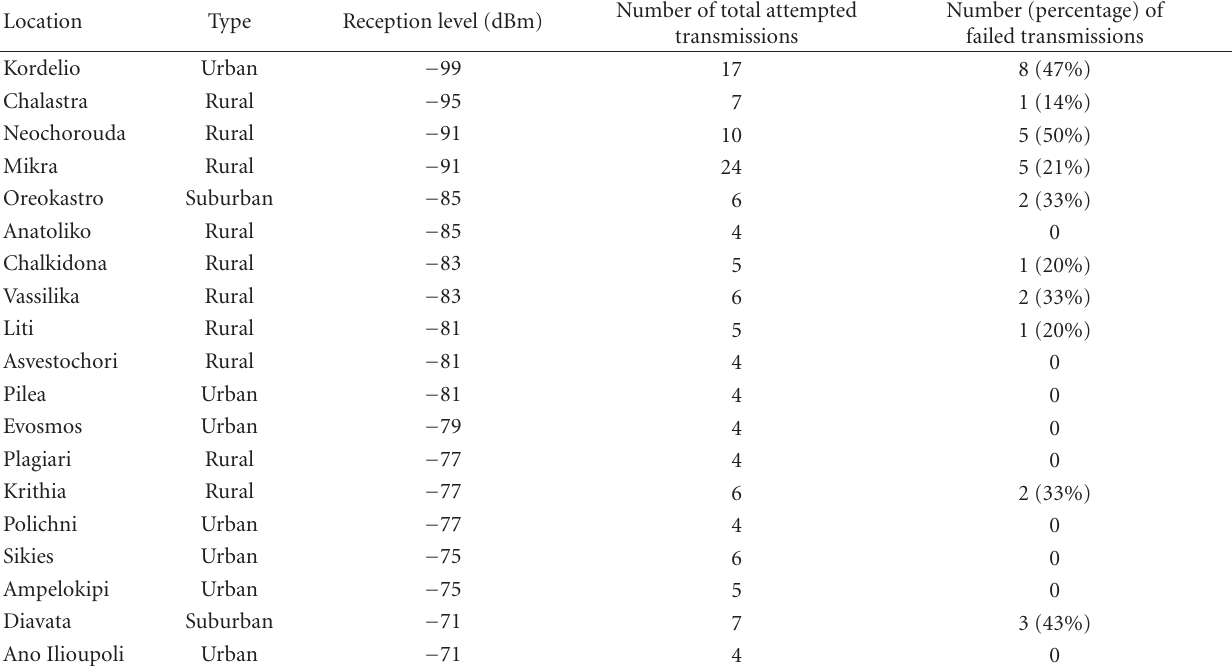
Table 2: A number of unsuccessful transmissions with GSM. Attempts were repeated until successful transmission. Only 34 of the total attempted transmissions concerned actual patient ECGs. The rest of the transmissions involved ECGs saved in the memory of the portable